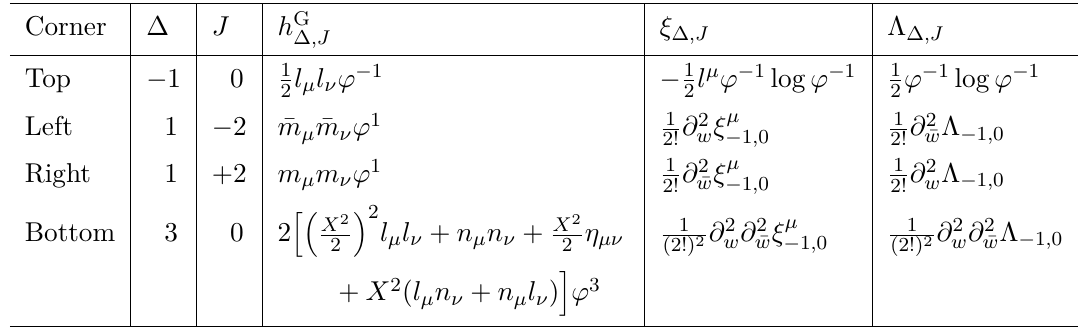
Table 16. Elements of the celestial diamond corresponding to supertranslation symmetry.